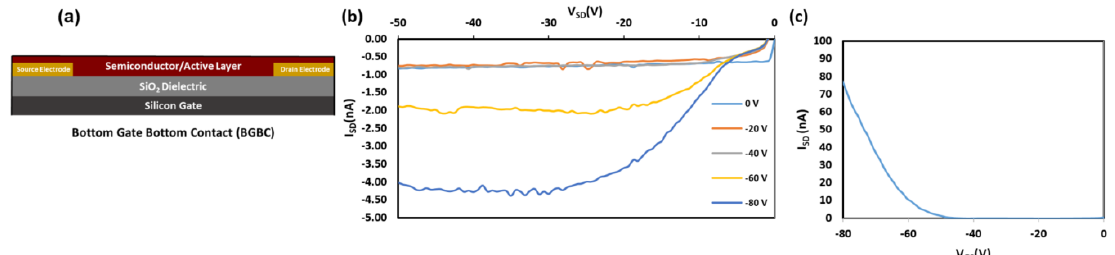
Figure 6. ( a ) Bottom gate bottom configuration used for organic thin film transistor (OTFT) integration of compounds 1b and 2a–d. ( b ) Characteristic output curve of fabricated OTFTs (1b). ( c ) Characteristic transfer curve of fabricated OTFTs (1b). Table 2. P-type OTFT testing summary a of compounds 1a–c and 2a–d. π – π Distance (Å)